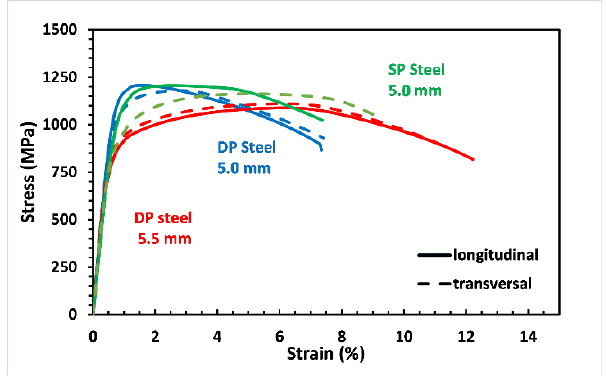
Figure 4. By a thickness reduction of 9% mechanical properties of DP steel change, higher yielding and maximum strength are accompanied by an elongation reduction (see the blue line).